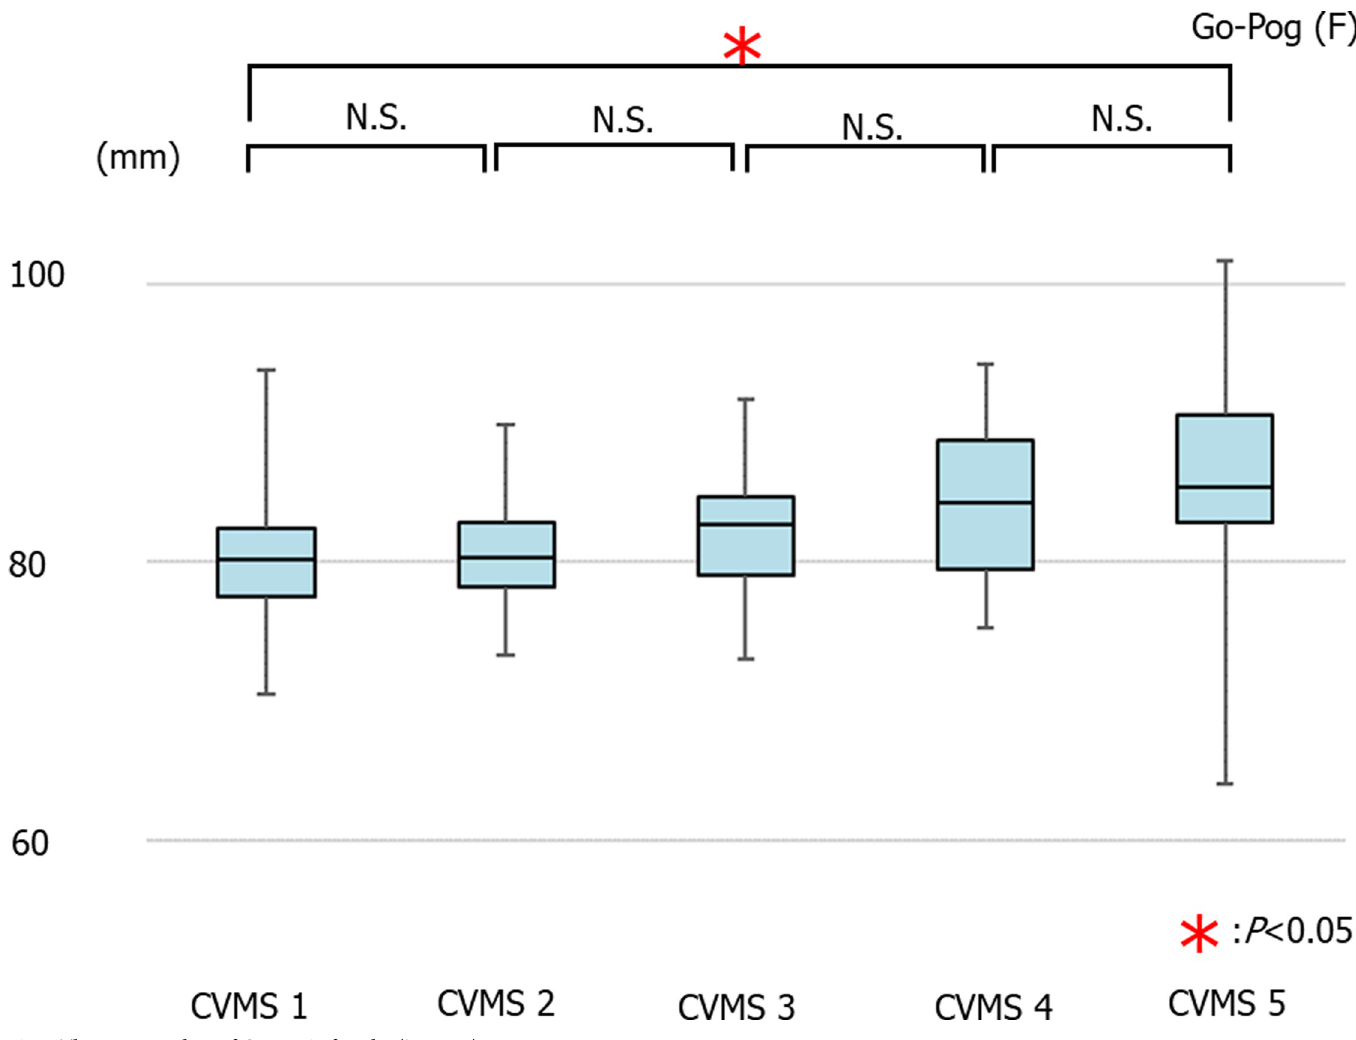
Fig 7. The average values of Go-Pog in females ( � p <